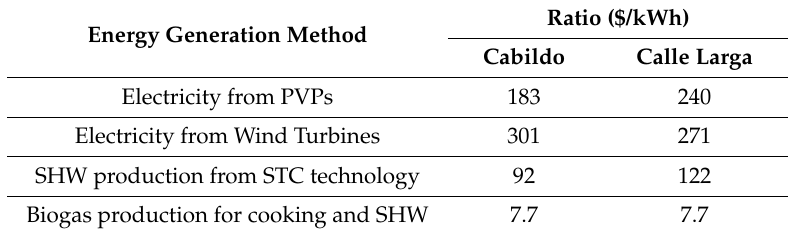
Table 9. Cost of SHW production using an STC, evaluated in Chilean pesos (CLP) and the ratio $/kWh to energy production, in the sector of Cabildo and Calle